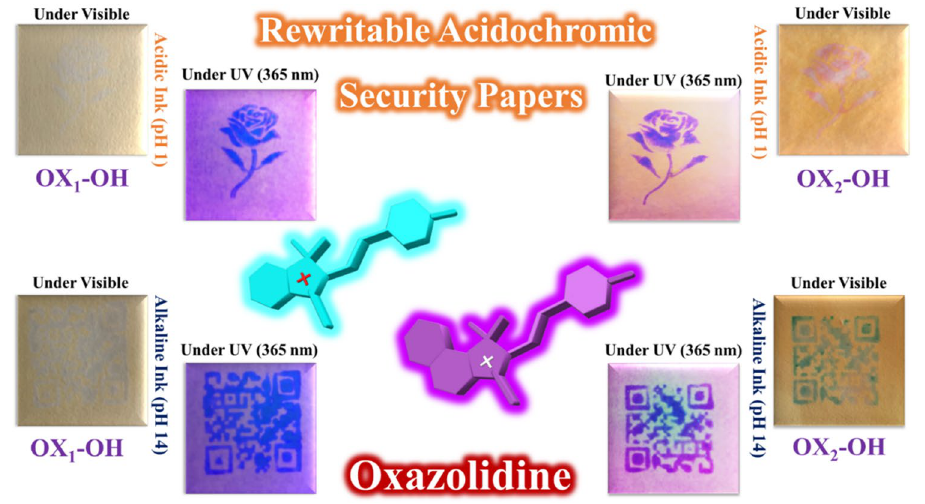
Figure 11. Printing of security marks and tags on OX 1 -OH and OX 2 -OH acidochromic papers by stamping of acidic (pH 1) and alkaline (pH 14) solutions as water-based